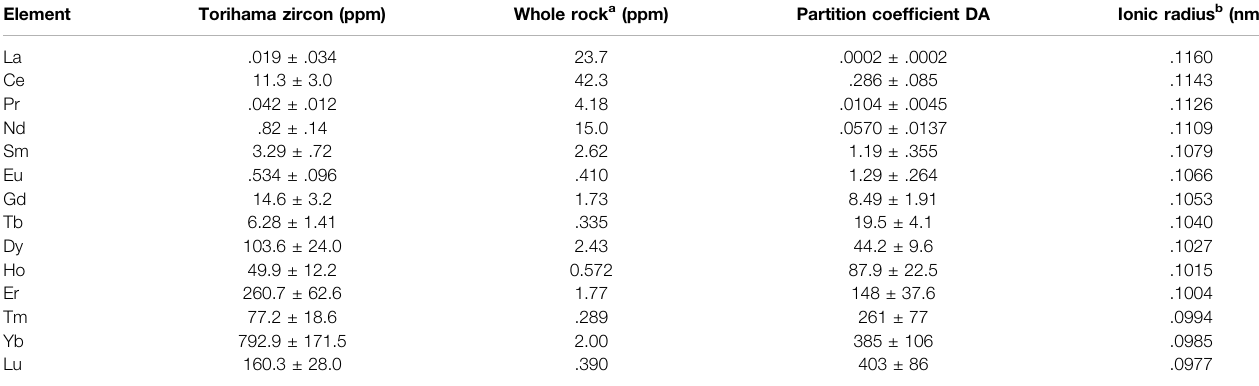
TABLE 4 | Rare earth elements concentrations in Torihama zircon and its host rock. Estimated partition coef fi cients together with ionic radius are also listed. Element Torihama zircon (ppm)